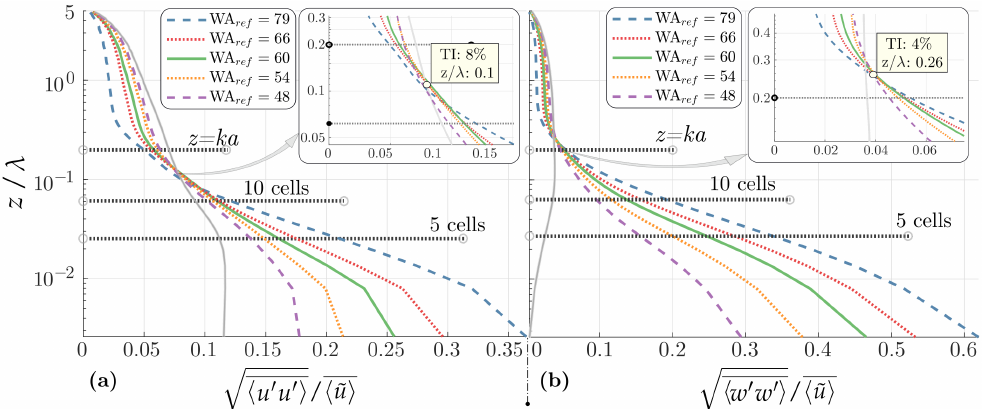
Figure 11. Turbulence intensity (TI) profiles averaged with t avg = 75 T 0 . TI for longitudinal and vertical velocity fluctuations, in ( a ) and ( b ), respectively. The light gray lines represent the case averaged flat-bottom solution. The zoomed regions depict the intersections between the